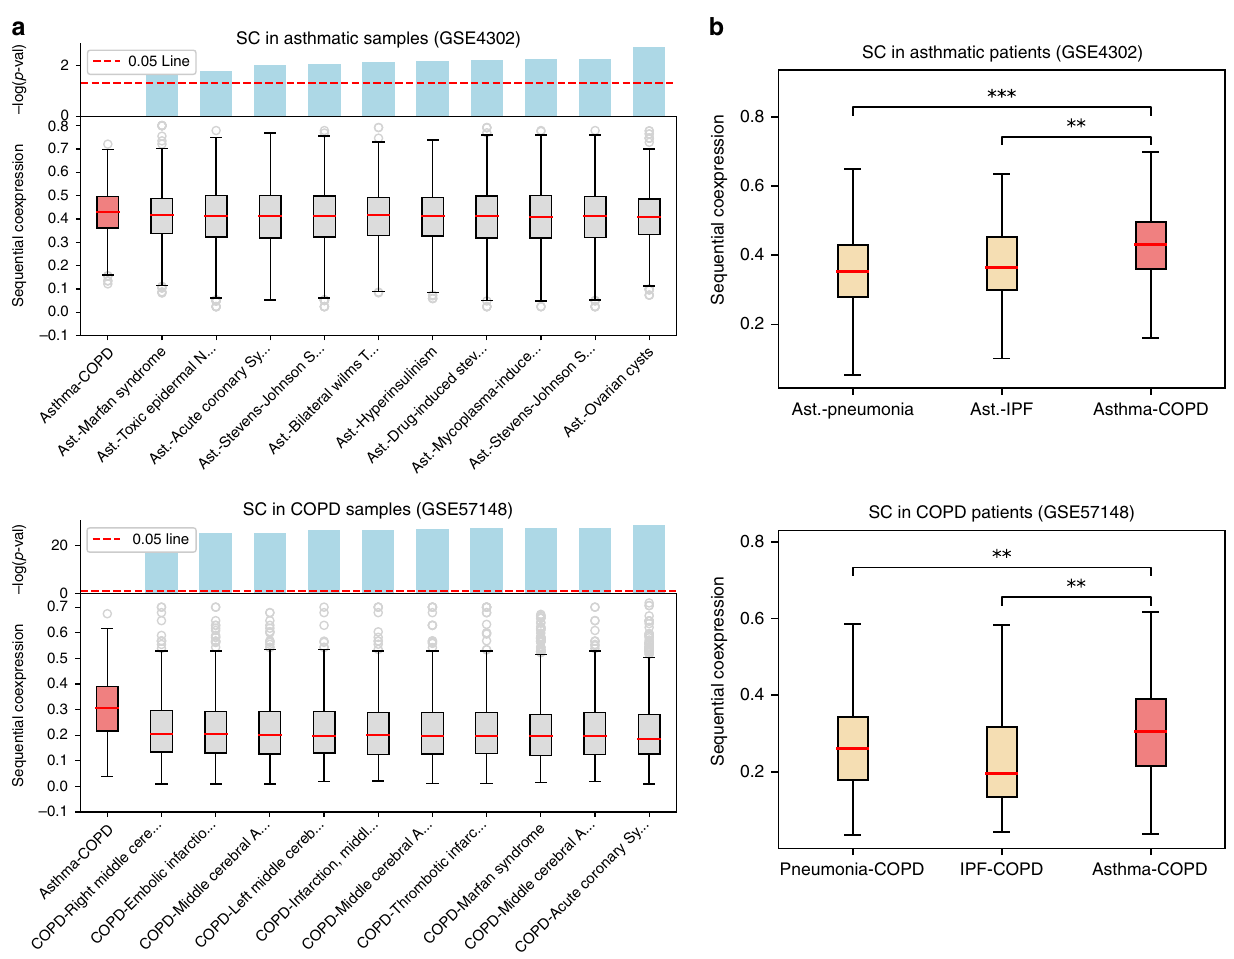
Fig. 5 Sequential coexpression of random paths connecting to unrelated phenotypes. a Sequential coexpression (SC) of the FC paths compared with random paths between the asthma module and each DisGeNet phenotype (top) and between the COPD module and each DisGeNet phenotype (bottom). For clarity only the top 10 phenotypes are shown, ordered by increasing signi fi cance. b (top) SC distribution of the asthma-COPD pair compared with SC of the asthma-pneumonia and asthma-IPF pairs, evaluated on asthmatic samples of GSE4302 data. b (bottom) SC distribution of the asthma-COPD pair compared with SC of the COPD-pneumonia and COPD-IPF pairs, evaluated on COPD samples of GSE57148 data. In the boxplots, boxes indicate the quartiles, whiskers extend to an additional 1.5 * IQR interval, and the medians are highlighted in red. One, two, and three asterisks, respectively, denote a Mann – Whitney p -value that is <0.05, 1e − 4, and 1e − 10, and “ n.s.'' stands for a non-signi fi cant